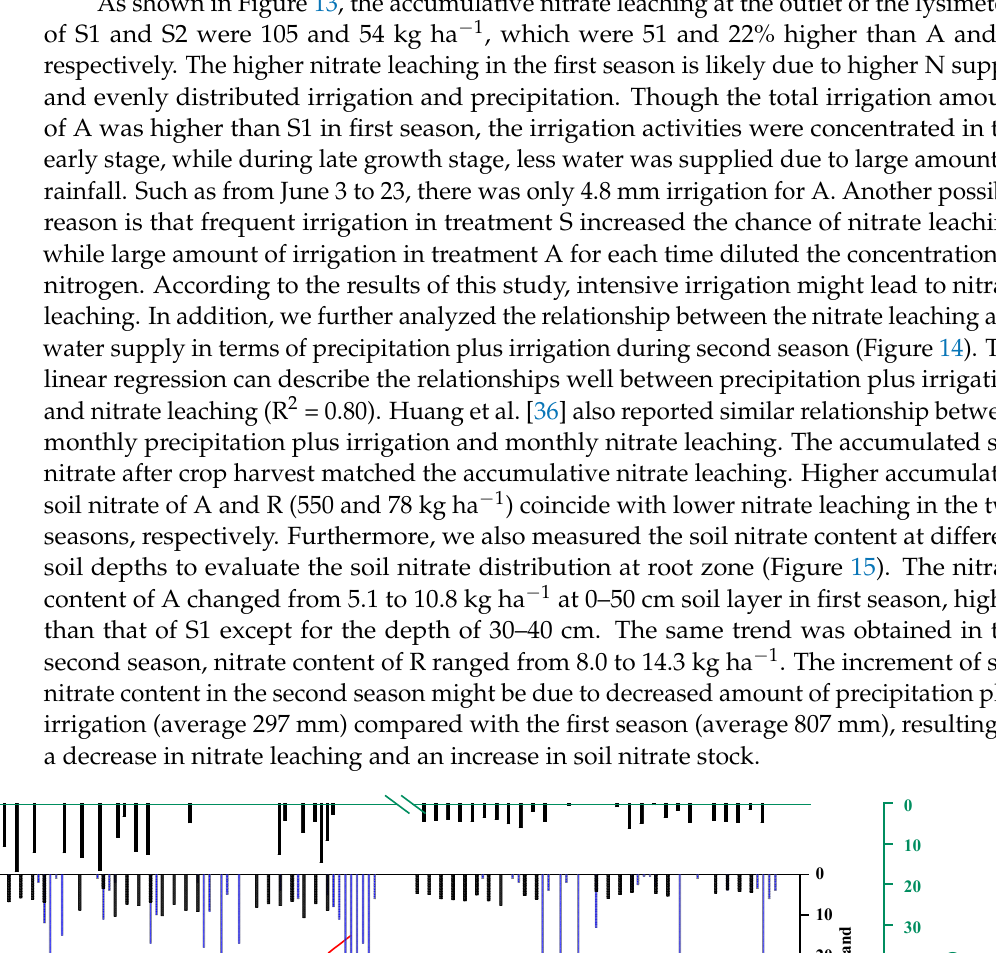
Figure 14. Linear regression between 10-day precipitation plus irrigation and 10-day nitrate leach- ing at 2 m soil depth in second season.